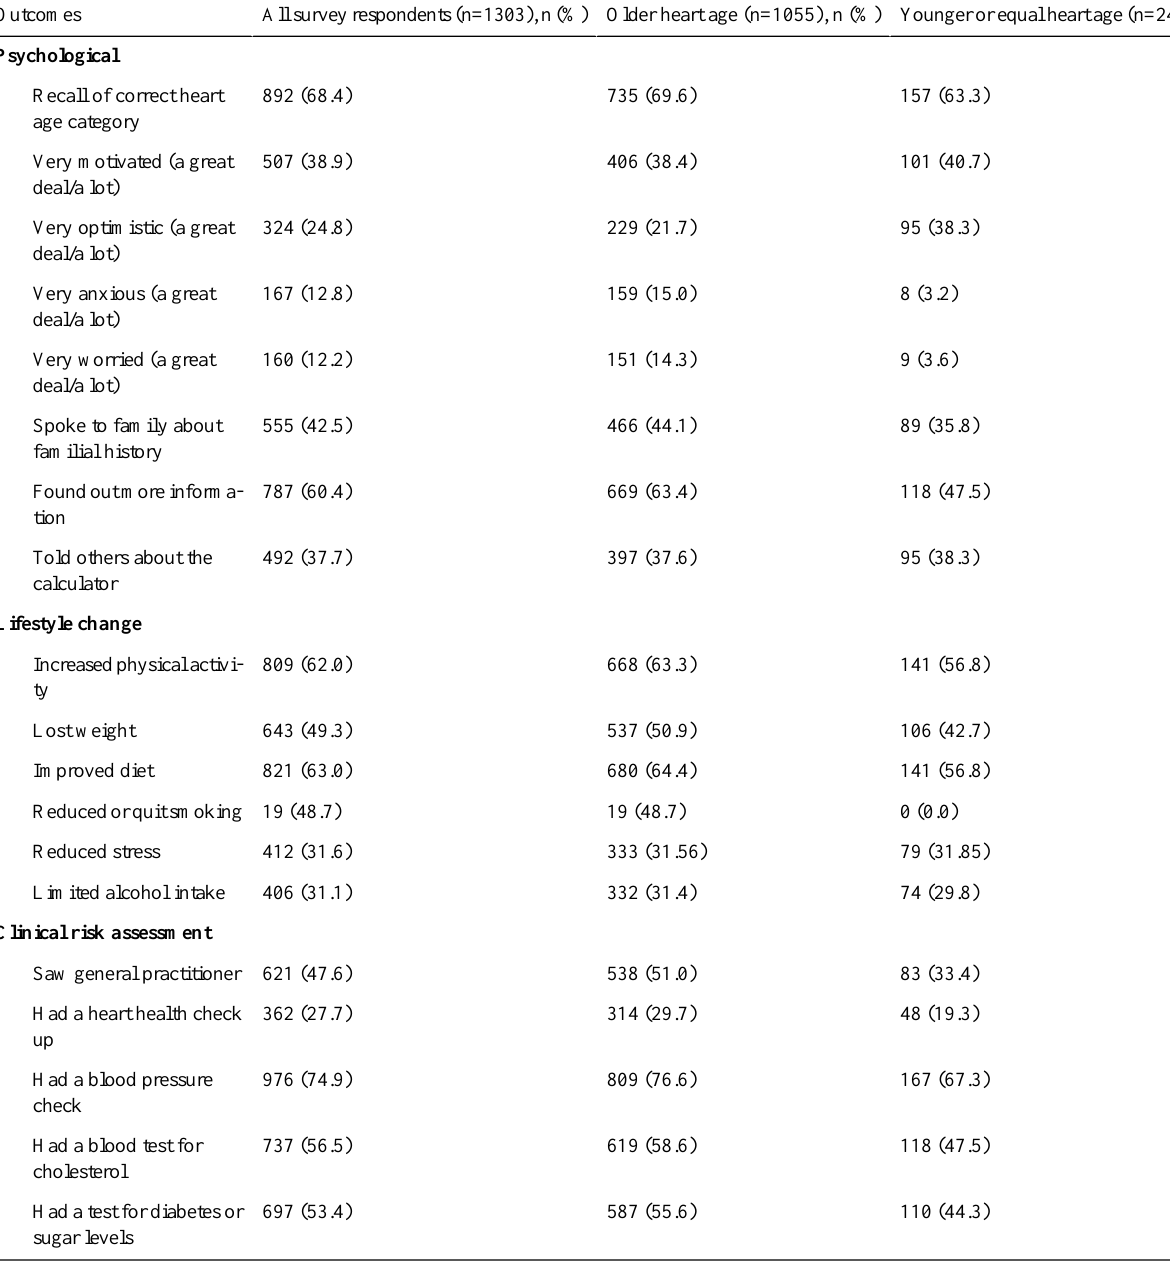
Table 2. Heart age calculator user outcomes after 10 weeks for survey